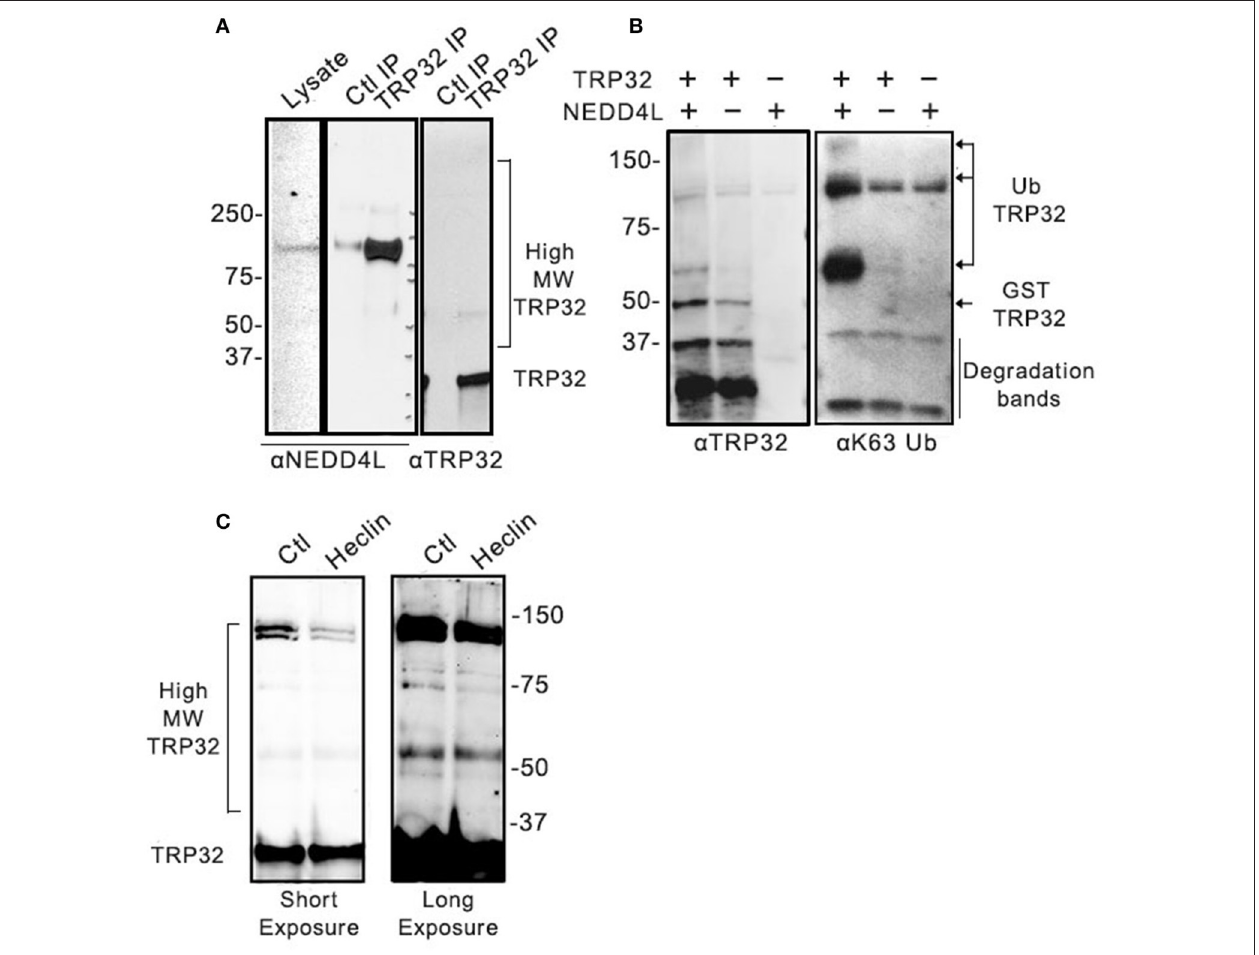
FIGURE 3 | Host NEDD4L E3 ligase conjugates TRP32 with K63-linked polyUb chains. (A) Immunoprecipitation of NEDD4L with anti-TRP32 demonstrating interaction in E. chaffeensis- infected cells. The resulting eluate was probed with anti-NEDD4L and anti-TRP32 antibody by immunoblot. (B) NEDD4L conjugates K63-linked polyUb chains to TRP32 in vitro . An in vitro assay was performed in the presence or absence of NEDD4L and the resultant reaction was immunoblotted with anti-TRP32 and anti-K63-linked polyUb-specific antibodies. Bands corresponding to K63 linked polyubiquitinated TRP32 (arrow) were increased in the presence of NEDD4L. (C) Treatment with the E3 ligase inhibitor, heclin, decreased TRP32 higher molecular weight bands . E. chaffeensis -infected THP-1 cells were incubated with heclin (25 uM) for 12h before harvesting lysate and immunoblotting with anti-TRP32 specific